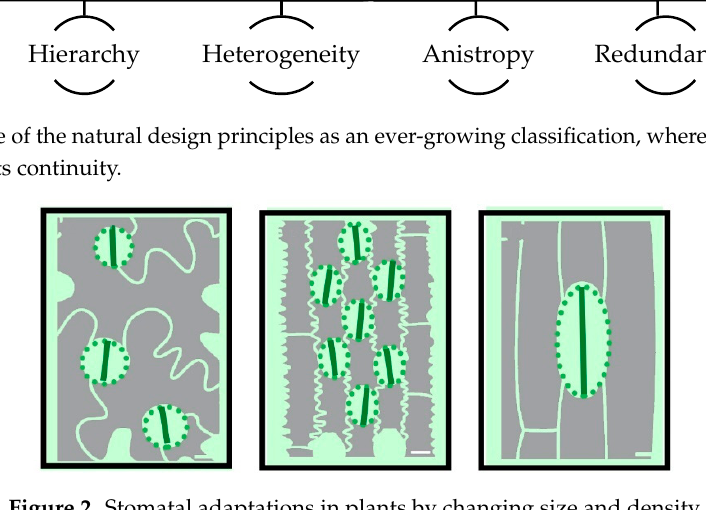
Figure 2. Stomatal adaptations in plants by changing size and density.